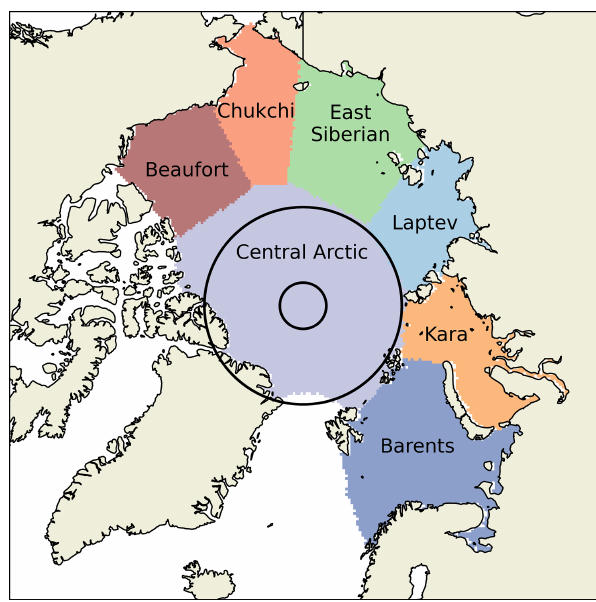
Figure 1. The definitions of the marginal Arctic seas used in this paper, from Stroeve et al. (2014). Two black, concentric circles in- dicate the latitudinal limits of the CryoSat-2 (inner circle; 88 ◦ N) and Envisat (outer circle; 82.5 ◦ N)